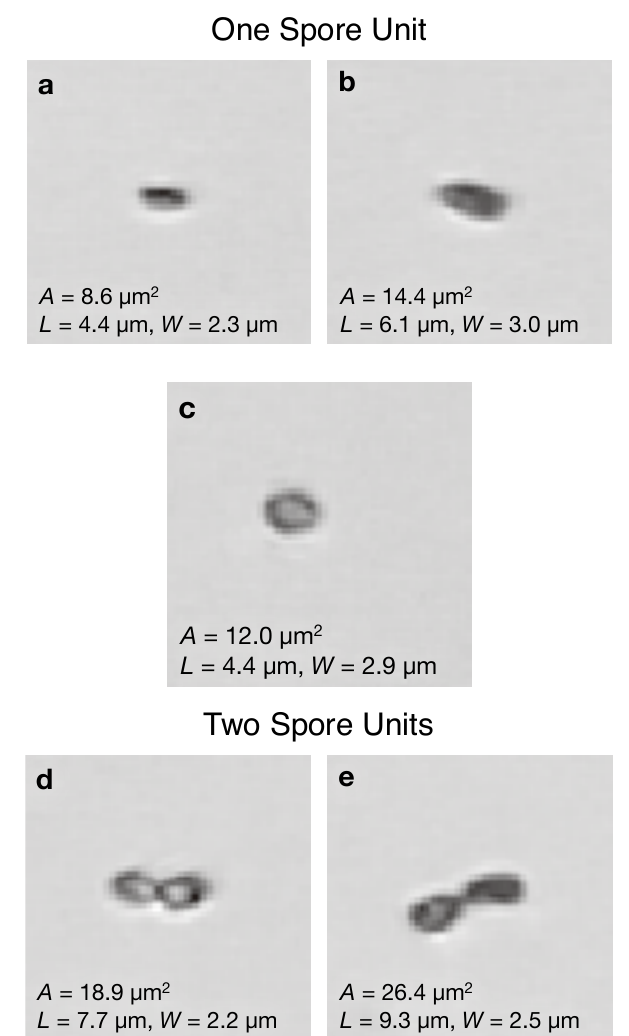
Fig. 4. Images of spores of Cladosporium collected on a glass slide and observed with the Olympus IX70 microscope at 40 × magnifi- cation. Panels ( a–c ) show dispersal units for Cladosporium contain- ing one spore, whereas panels (d and e) depict observations of two or more spores (comprising 10% of the total observations during size studies at the 20 × magnification level). Each image measures 20µm × 20µm . Measurement values for area (A) , length (L) , and width (W) are provided in each panel.